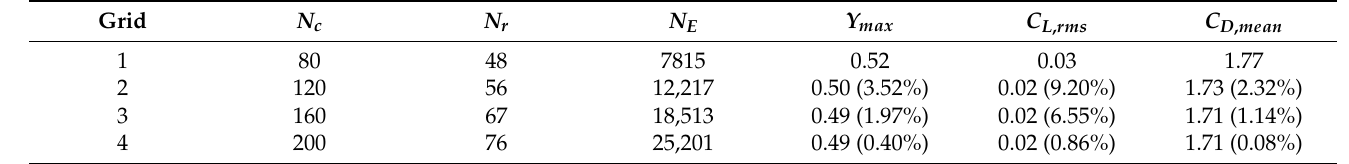
Table 3. Dependence of numerical results on the grid resolution. All the numerical simulations were conducted at fixed values of Re = 150, m ∗ = 2.5465, ζ = 0, and U r = 6.